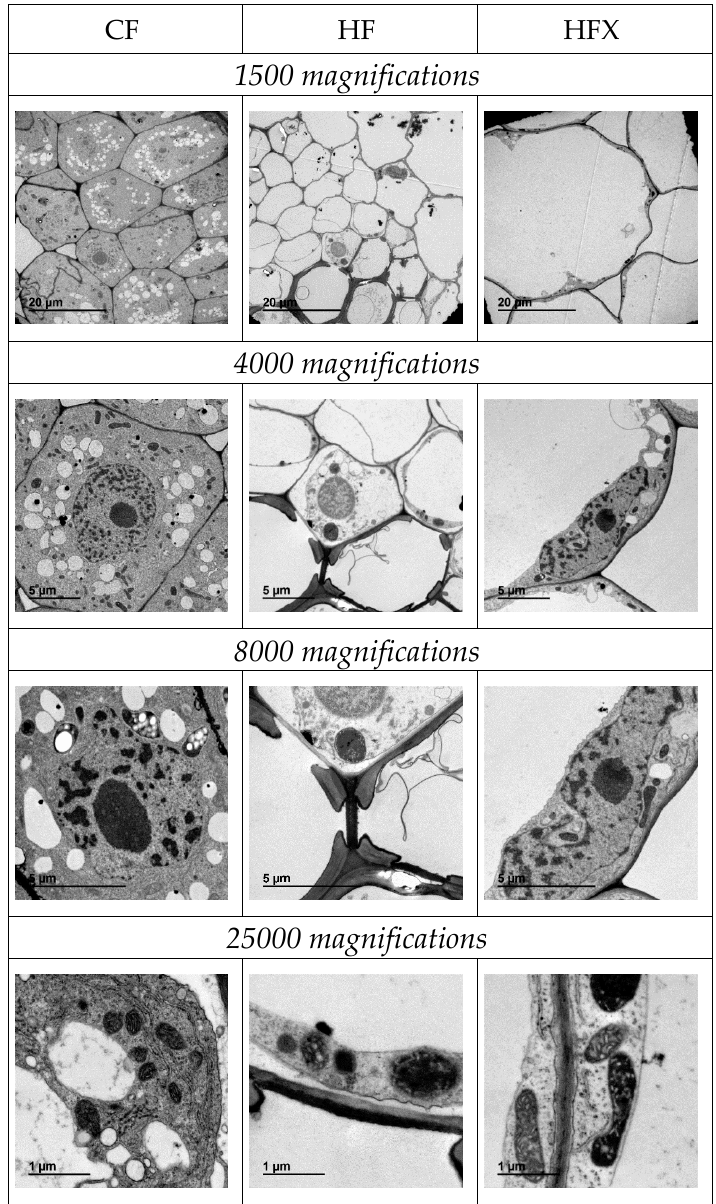
Figure 4. Transversal images of the roots of pepper plants fertigated with CF, HF and HFX nutrient solutions at 1500, 4000, 8000 and 25,000 magnifications obtained by transmission electron microscopy